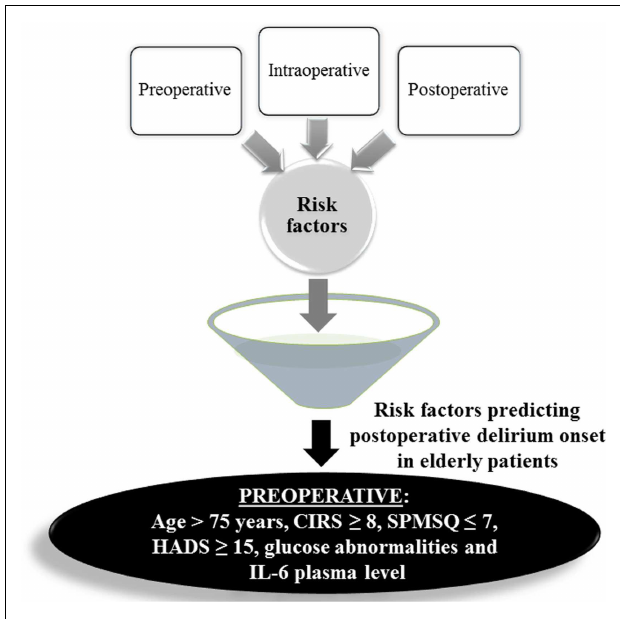
FIGURE 1 | Pre-, intra-, and post-operative risk factors were evaluated in univariate and multivariate analyses, depicted as a funnel; the numbers reported in the figure are referred to the previous work (14) . In this paper, by means of a sub-cohort of 74 patients (37 controls and 37 with POD), pre-operative IL-6 plasma level ( ≥ 9pg/mL) and age were found to be independent risk factors together with other pre-operative parameters, i.e., CIRS (cumulative illness rating scale), SPMSQ (short-portable mental status questionnaire), HADS (hospital anxiety and depression scale) showing that pre-operative variables are the most significant to predict POD